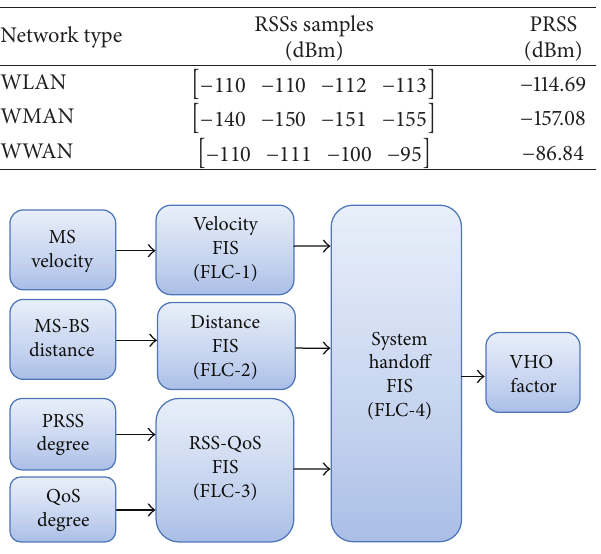
Figure 2: VHO factor calculations.